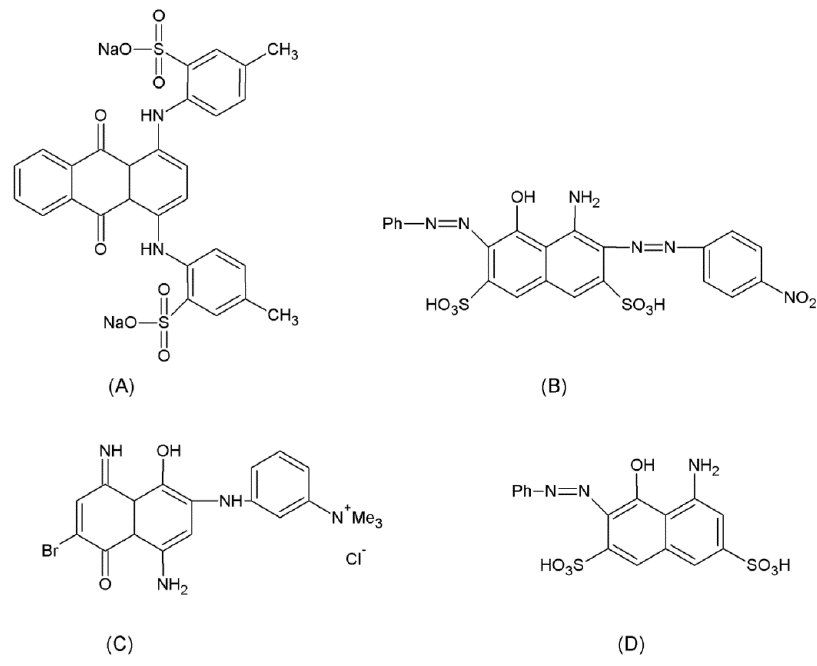
Figure 1. Chemical structure of Acid Green 25 hair dye ( A ), Acid Black 1 ( B ), Basic Blue 99 ( C ) and Acid Red 33 ( D